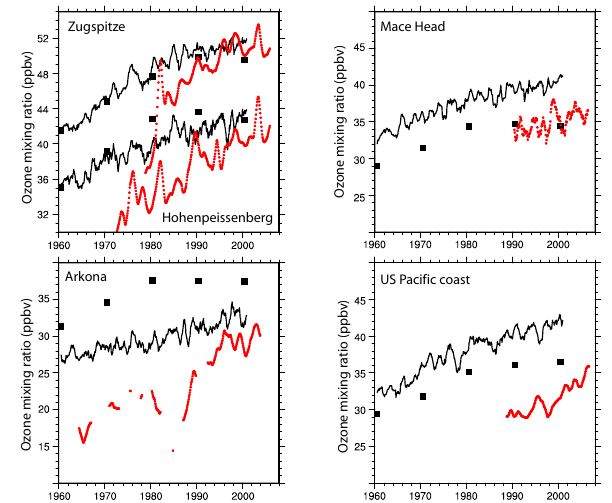
Table 11. Linear trend in surface ozone (ppbv/year)